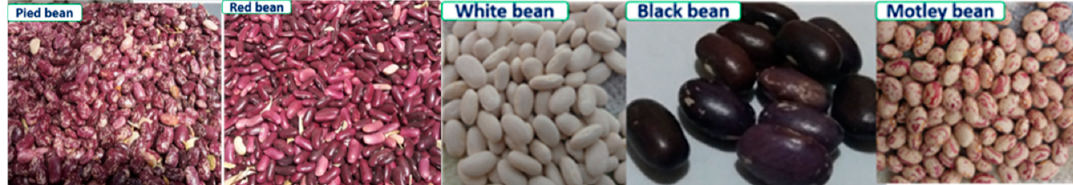
Figure 2. Seeds of five bean varieties planted in this study (from left to right): pied bean, red bean, white bean, black bean, and motley bean.